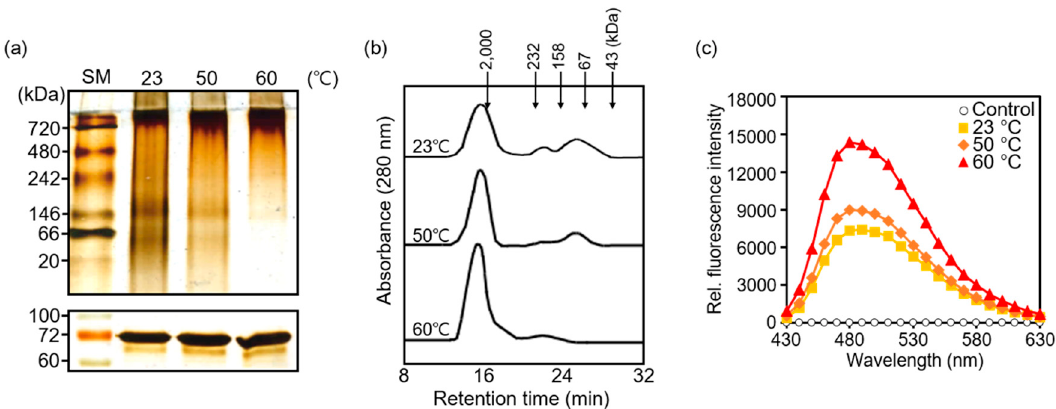
Figure 5. Heat shock-dependent changes in AtTPR10 structure and hydrophobicity. ( a ) Structural changes in AtTPR10 in response to the heat shock treatment. AtTPR10 was incubated at 23 °C, 50 °C, and 60 °C for 30 min, centrifuged at 13,000× g for 15 min, and analyzed by 10% native PAGE gel and silver staining. SM represents the size marker. ( b ) Size exclusion chromatography (SEC) analysis of AtTPR10 by HPLC. Recombinant purified AtTPR10 was heat-treated, as described in ( a ), and 2 mg of each protein sample was separated by SEC, based on the MW. ( c ) Heat-shock dependent changes in the surface hydrophobicity of AtTPR10. Recombinant AtTPR10 protein (20 μ g) was incubated with 10 μ M bis-ANS at 23 °C ( ■ ), 50 °C ( ◆ ), and 60 °C ( ▲ ) for 20 min. Incubation of 10 μ M bis-ANS with no AtTPR10 protein served as a control ( ○ ). The fluorescence intensity of bis-ANS was measured at an excitation wavelength of 390 nm and emission spectra of 430–630 nm.